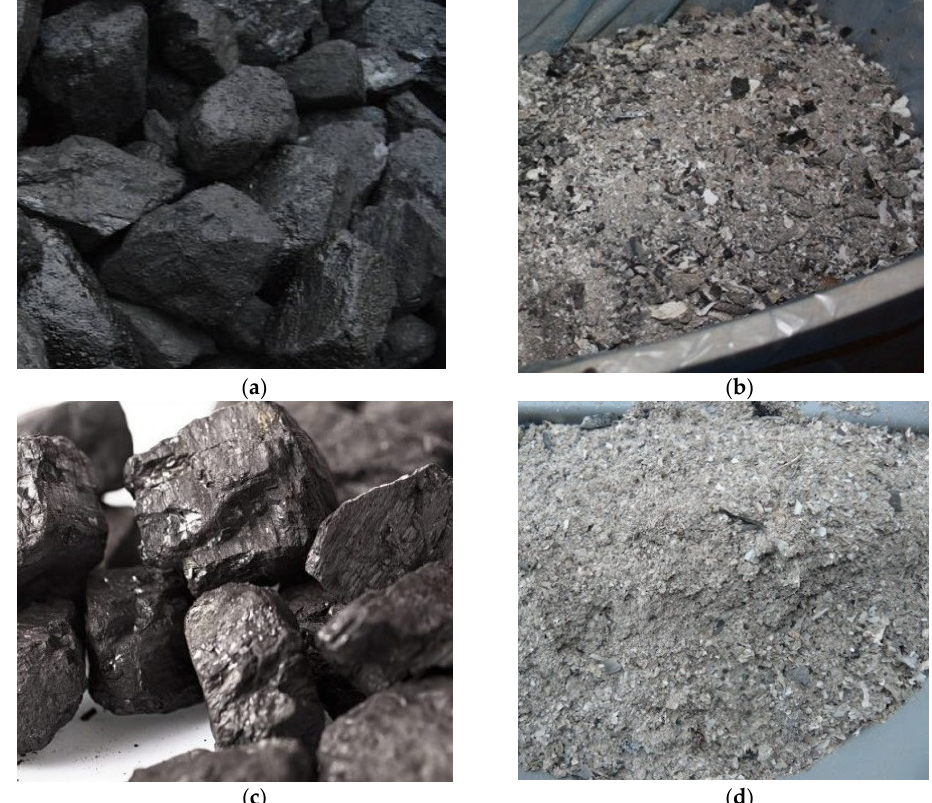
Figure 2. Research material: hard coal ( A ), ash from hard coal ( B ), eco-pea coal ( C ), and ash from eco-pea coal ( D ).